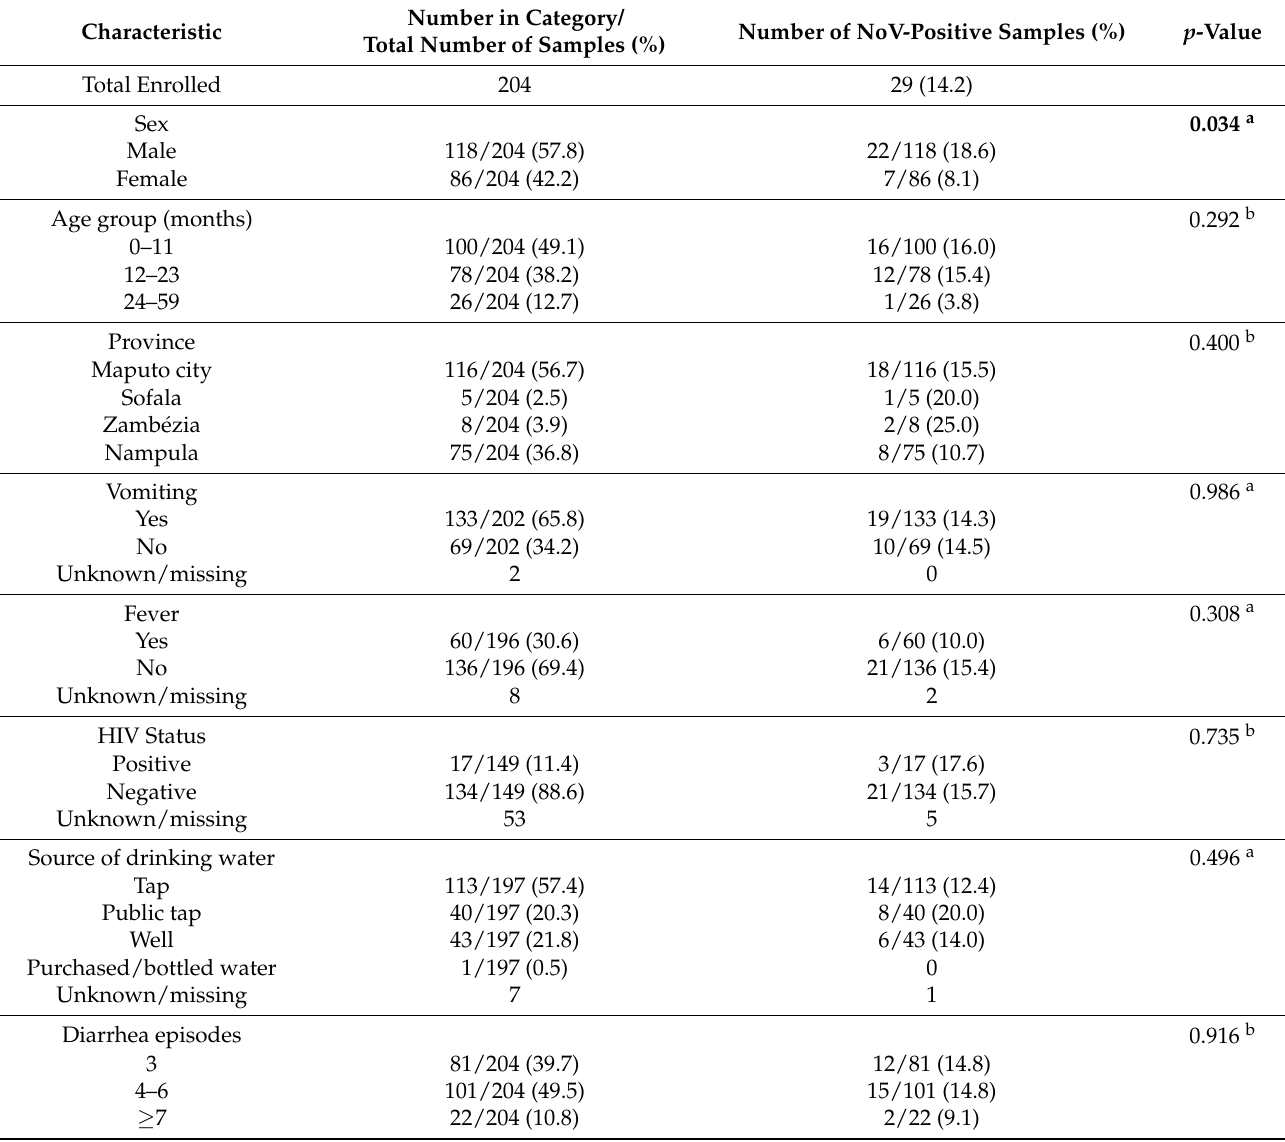
Table 2. Socio-demographic and clinical characteristics of children under five years old with and without norovirus in Mozambique 2014–2015 ( n =